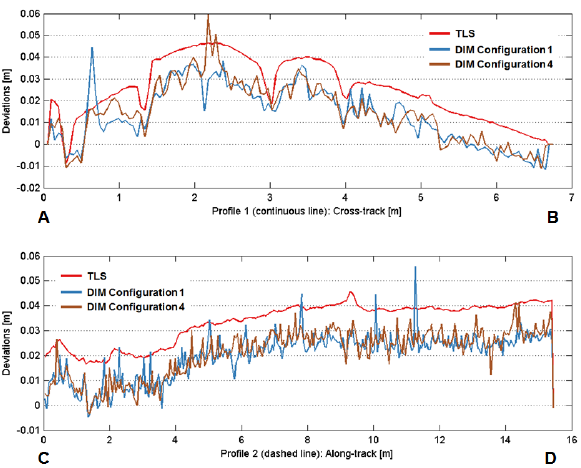
Figure 14. Cross-track and along-track profile of road patch 2